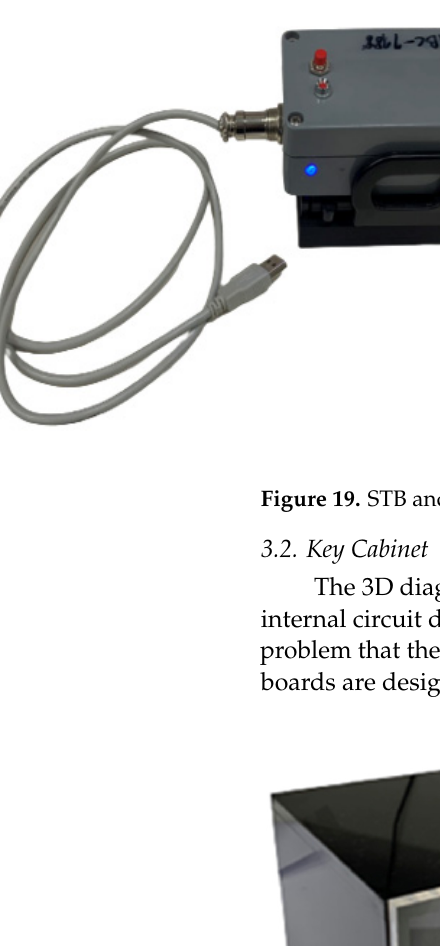
Figure 18. Physical product of the set-top box.